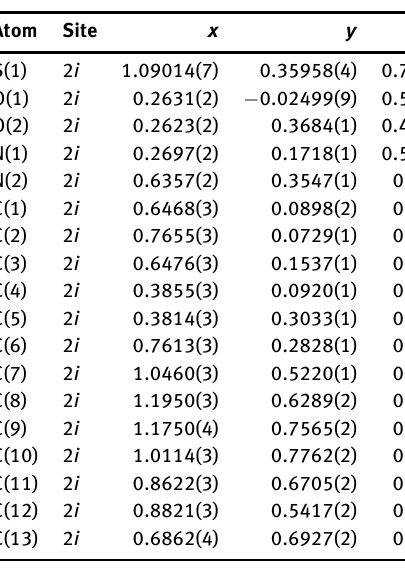
Table 3: Fractional coordinates and atomic displacement parameters (Å 2